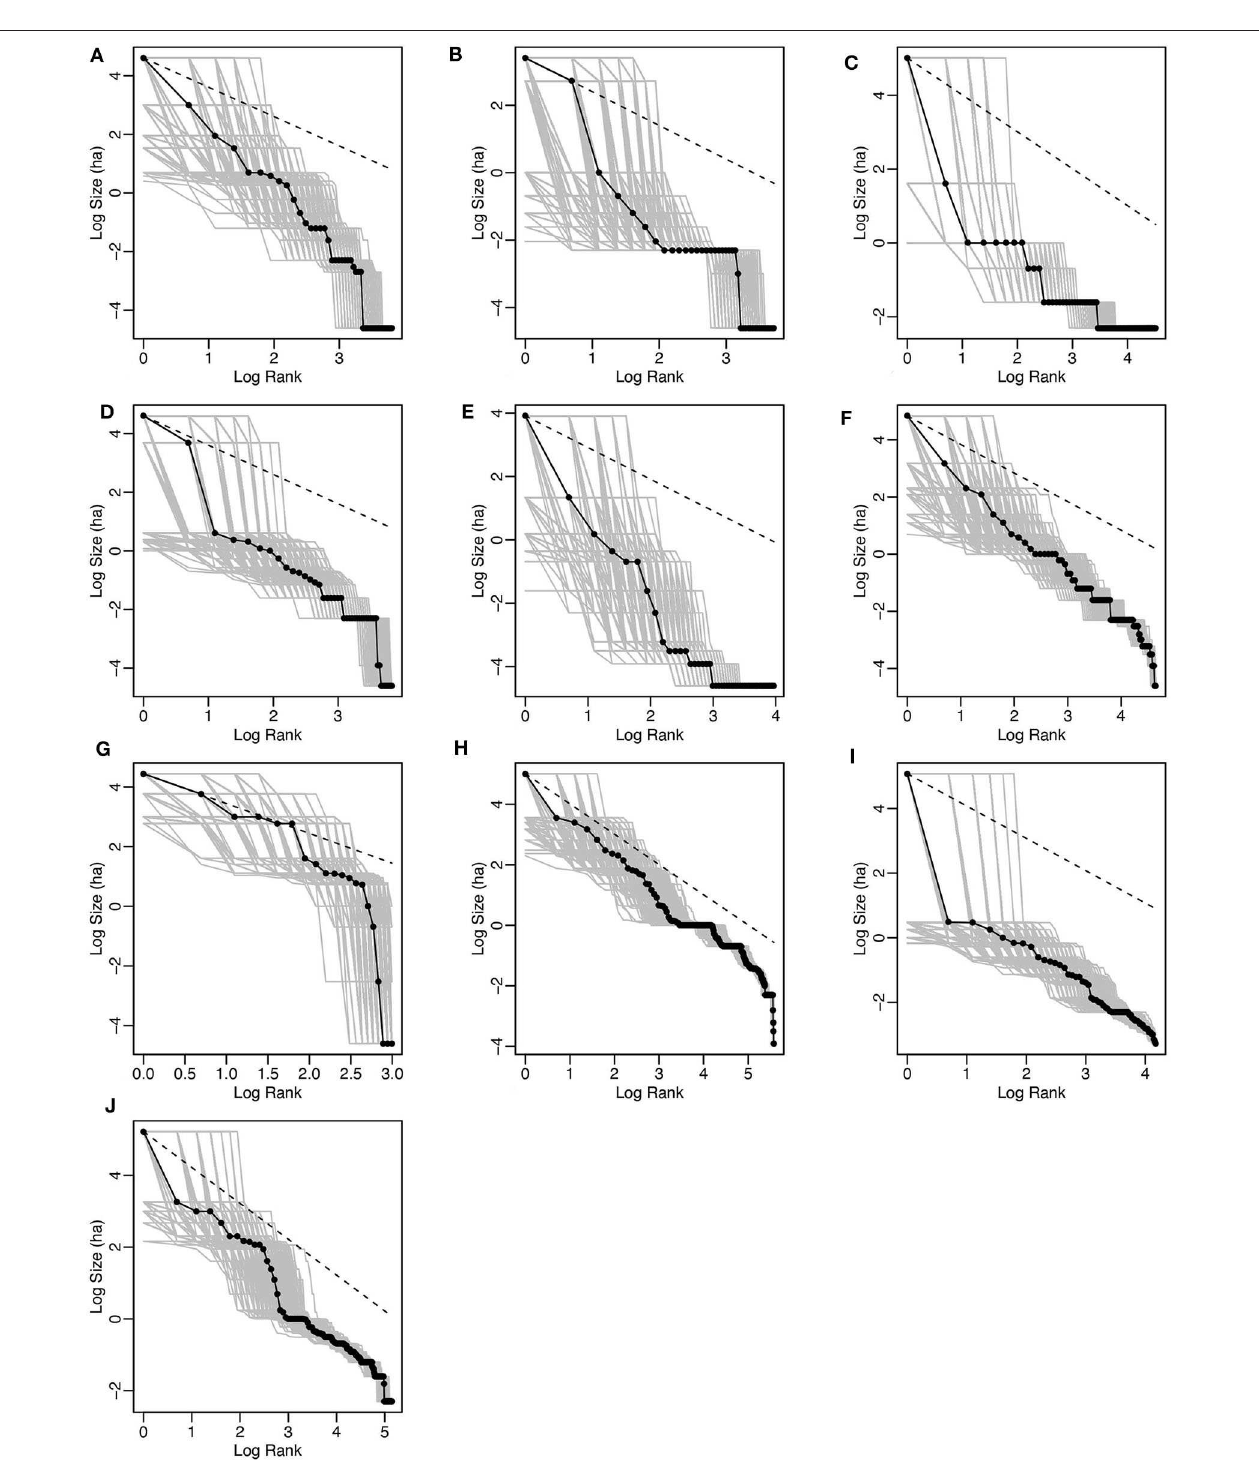
FIGURE 9 | Rank size for the territories of Post-Archaic centres with sufficient data points. (A) Volterra, (B) Fiesole, (C) Populonia, (D) Vetulonia, (E) Chiusi, (F) Vulci, (G) Orvieto, (H) Tarquinia, (I) Cerveteri, (J) Veio. The dark line represents the observed data. The grey lines represent the bootstrap results performed on random samples of